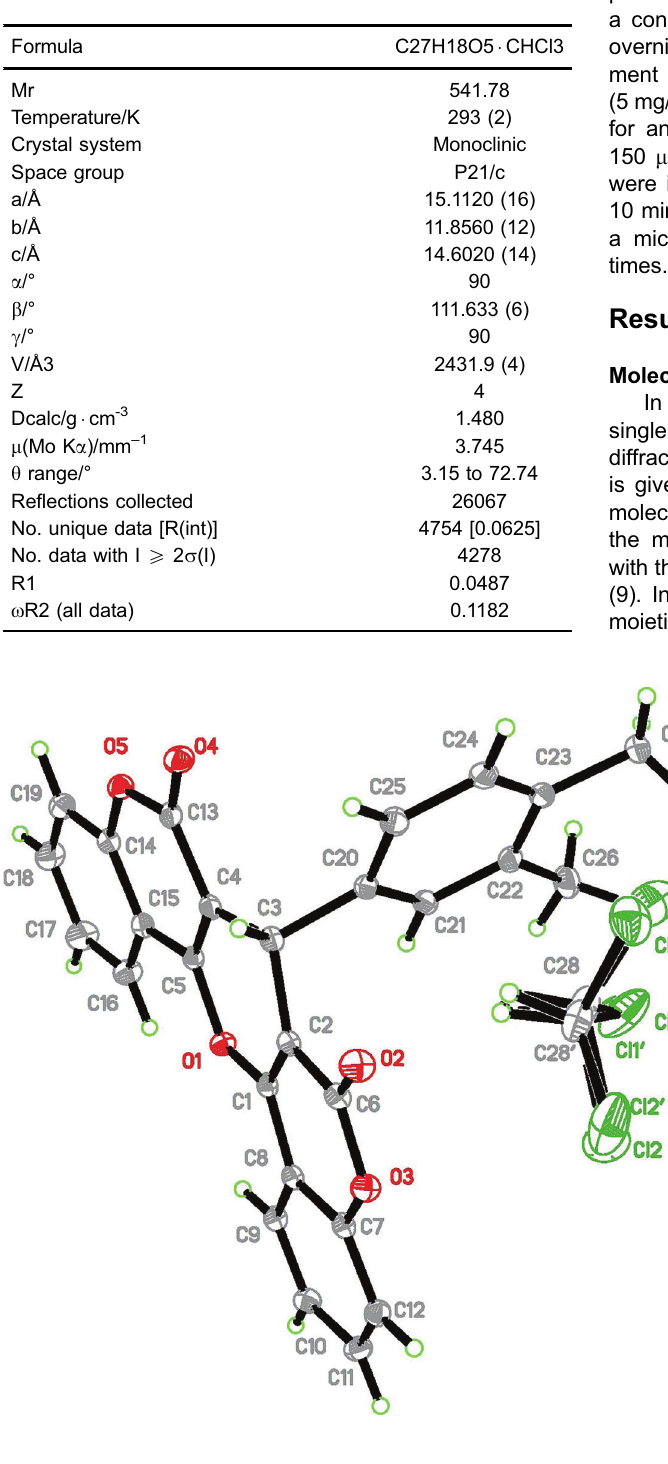
Table 1. Crystal data and structure re fi nements for compound I